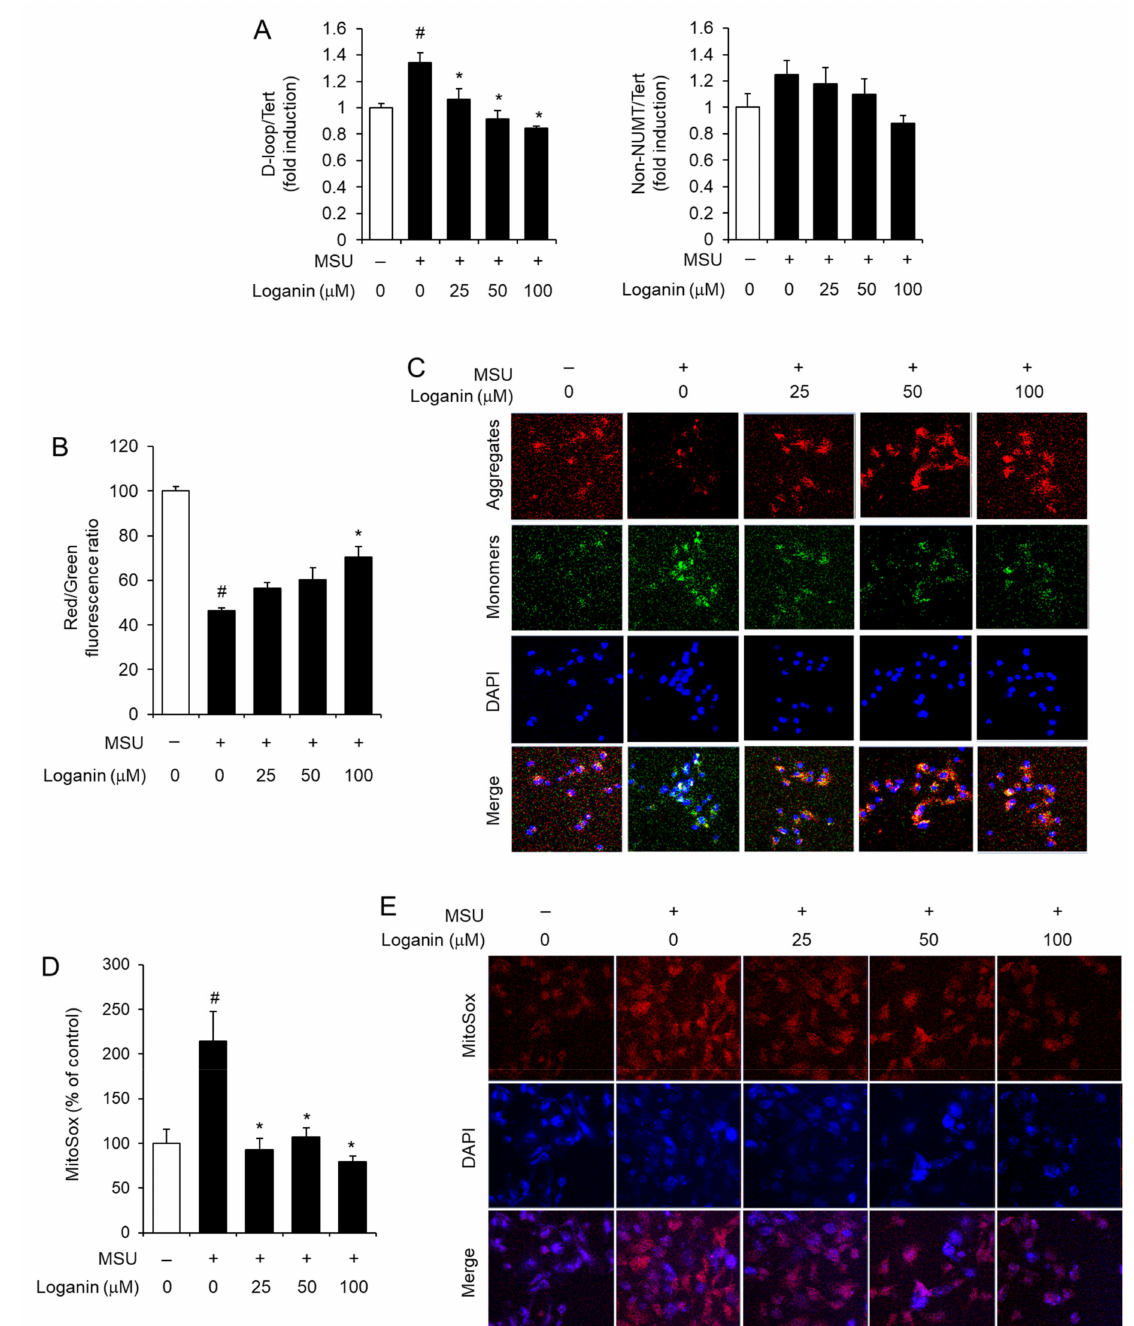
Figure 5. Loganin prevents mitochondrial dysfunction induced by MSU crystals in primary mouse macrophages. After LPS priming, BMDMs were treated with loganin for 1 h. Then, the cells were further stimulated with MSU crystals (500 µ g/mL) for ( A ) 6 h or ( B – E ) 2 h. ( A ) The levels of mitochondrial DNAs such as D-loop and non-NUMT were determined by qPCR analysis. ( B , C ) For the measurement of mitochondrial membrane potential, BMDMs were stained with JC-1 (2 µ M). ( B ) Red/green fluorescence ratios were determined with a fluorescence plate reader or ( C ) fluorescent images were obtained by confocal microscopy (magnification × 400). DAPI was used for nuclei staining. ( D , E ) For the measurement of mitochondrial reactive oxygen species, BMDMs were loaded with MitoSOX-Red (5 µ M). ( D ) Fluorescence was determined by a fluorescence plate reader, or ( E ) fluorescent images were obtained by confocal microscopy (magnification × 400). The values in ( A , B , D ) represent the means ± SEM ( n = 3); # significantly different from vehicle alone, p < 0.05; * significantly different from MSU alone, p <